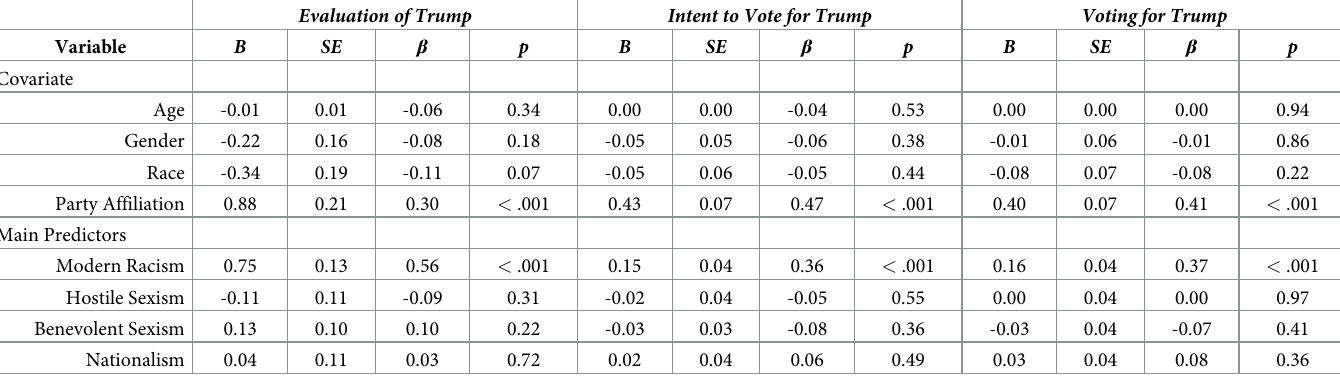
Table 7. Standardized estimates, unstandardized estimates, and standard errors for structural model predicting evaluation of Trump, intent to vote for Trump, and voting for Trump at Time 2. Evaluation of